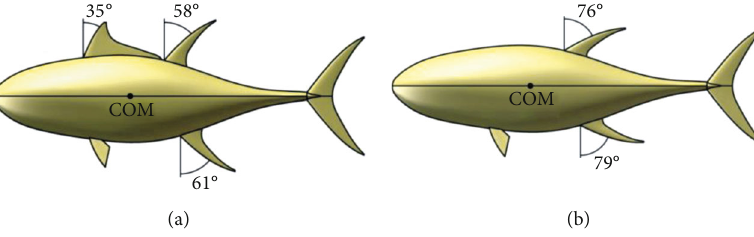
Figure 2: The morphing states of the median fi ns. (a) All median fi ns are erected. (b) All median fi ns are